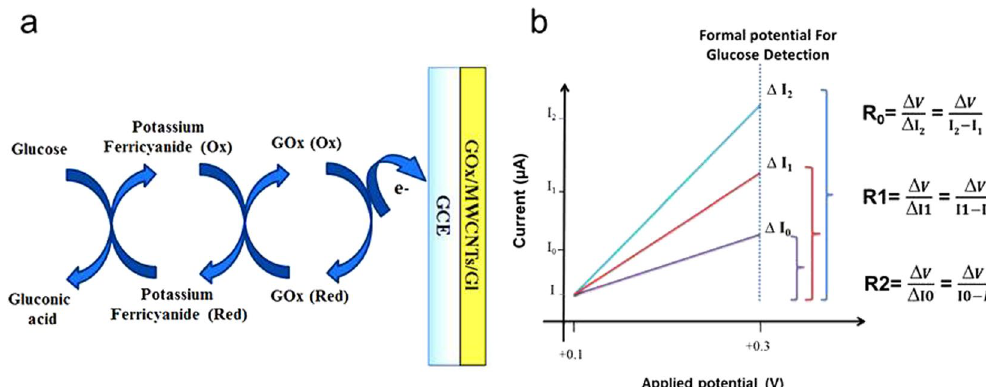
Figure 3. Variation of resistance in the electrochemical cell during glucose detection ( a ) Sequence of events that occur in mediator-based glucose biosensors in the electrochemical cell. ( b ) Output voltage of the pulse generator after the first, second, and third glucose drop into the electrochemical